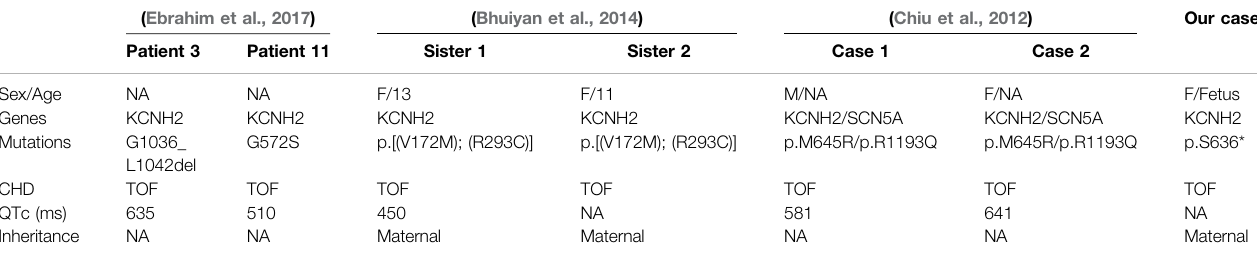
TABLE 2 | KCNH2 mutations in patients who had LQTS combined with tetralogy of fallot in the literature. (Ebrahim et al.,